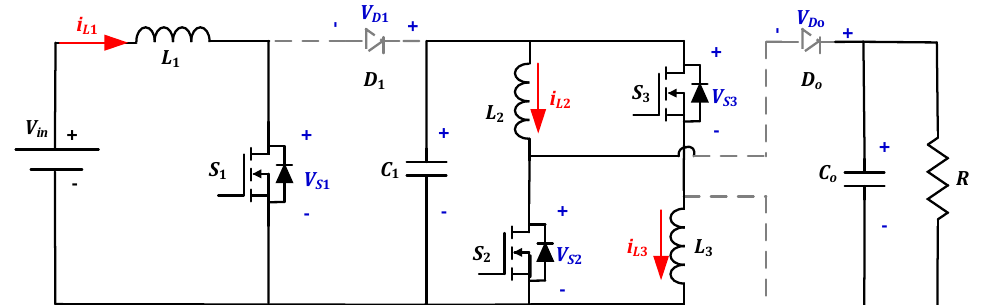
Figure 4. The configuration of mode I.